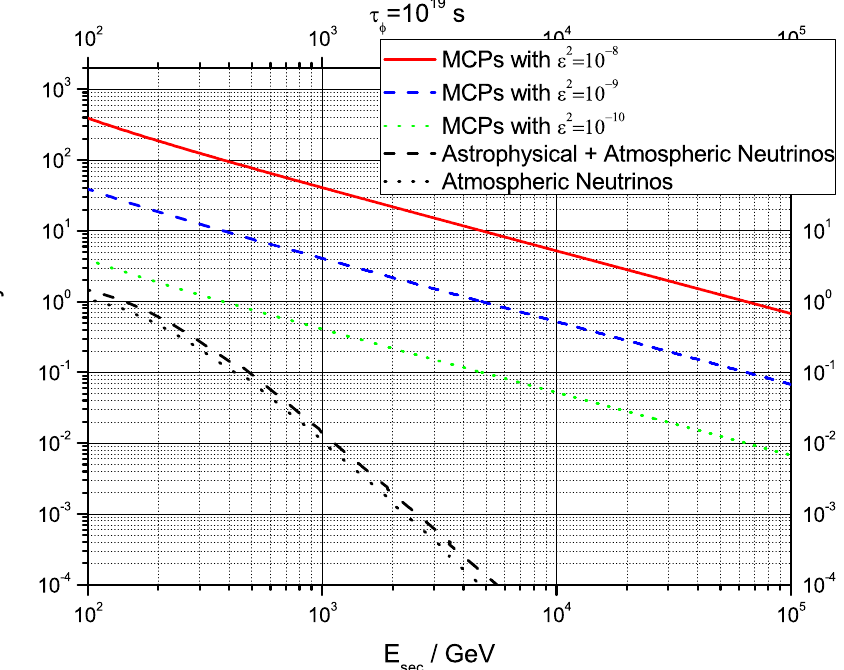
Figure 2 . With the different (cid:15) 2 (= 10 − 10 , 10 − 9 and 10 − 8 ), the numbers of expected MCPs were evaluated assuming 6 years of IceCube data, respectively. The evaluation of numbers of expected neutrinos was performed by integrating over the regions caused by one standard energy and median angular